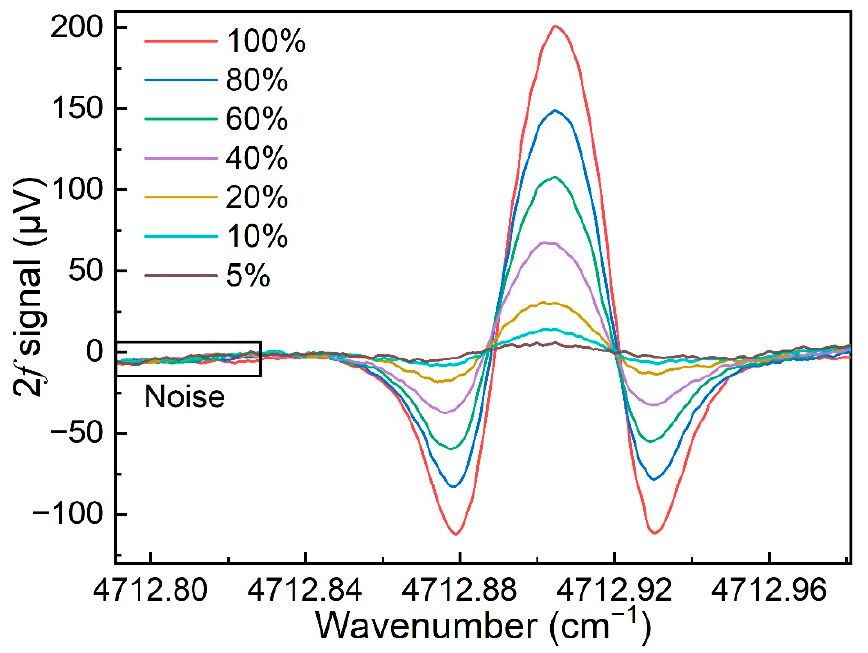
Figure 5. The 2 f signal for the TDLAS sensor with respect to different concentrations of H 2 in the H 2 -TDLAS sensing system.